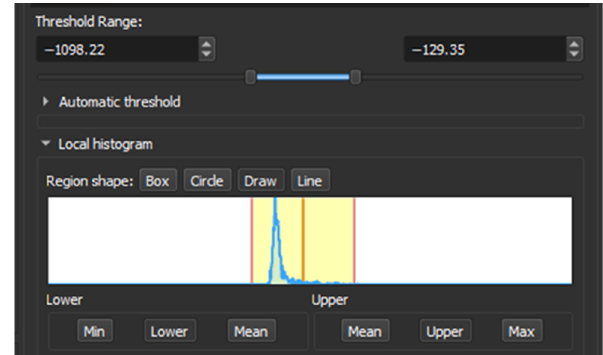
Figure 1. Local Histogram from 3D Slicer.